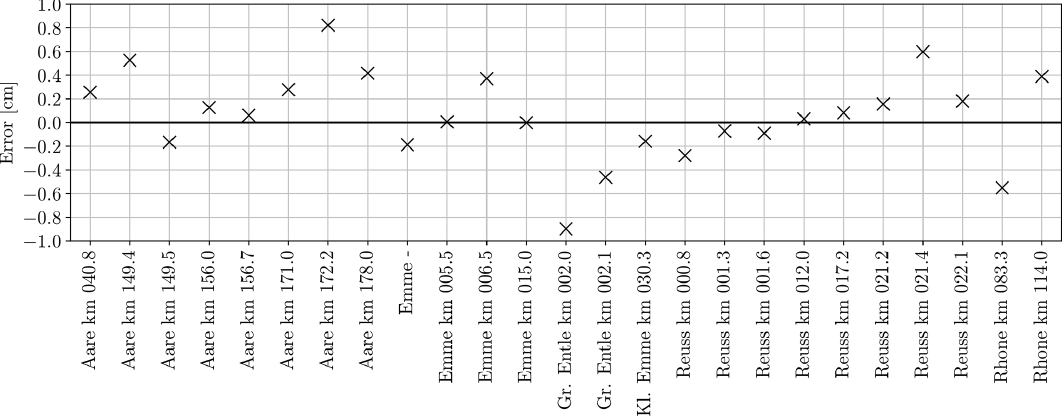
Figure 15. Error of the mean d m per gravel bar derived from the GRAINet end-to-end d m predictions.